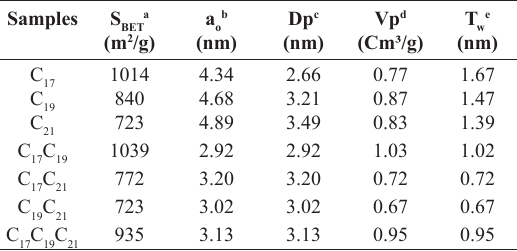
Table 2. Physico-chemical parameter of materials.